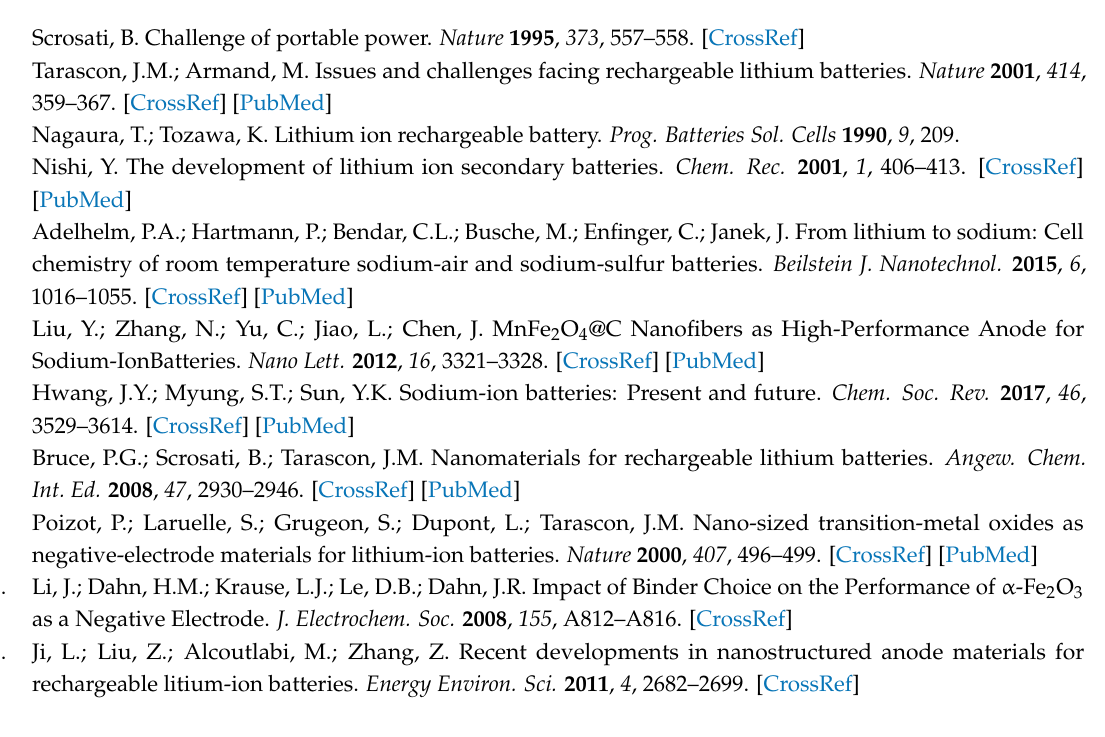
Figure S1: SEM images of (a) NiO_air, (b) NiO_18%C and (c) NiO_29%C samples, Figure S2: Hysteresis loops at room temperature of the NiO_air, NiO_18%C and NiO_29%C samples, Figure S3: Ex-situ XRD patterns of the NiO_29%C sample and the discharged and charged electrodes, Figure S4: Hysteresis loops at room